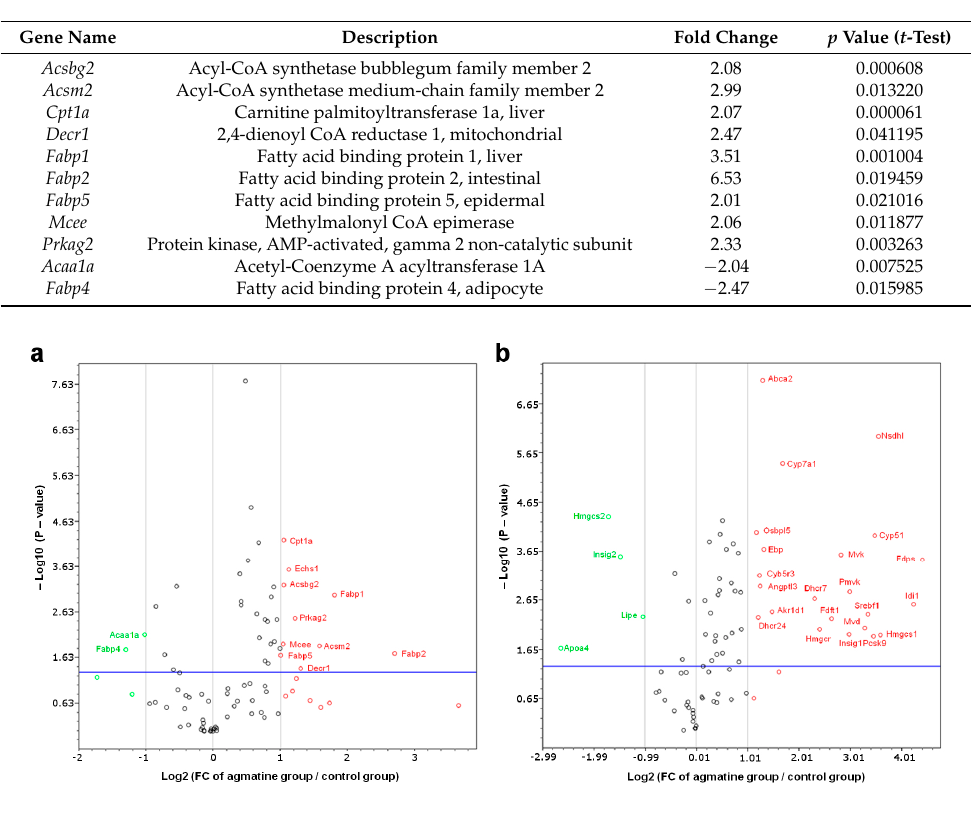
Figure 3. Volcano plot graphs of mouse fatty acid metabolism PCR array ( a ) and mouse lipoprotein signaling and cholesterol metabolism PCR array ( b ). Graphs show the log 2 of fold change of gene expression between the agmatine group and control group versus p value from the t test. ◦ up-regulation, ◦ down-regulation. Blue line indicates threshold 0.05 for p value. Table 4. The genes involved in lipoprotein signaling and cholesterol biosynthesis that showed differential expression between agmatine group vs. control group (fold change > 2.0, p < 0.05).